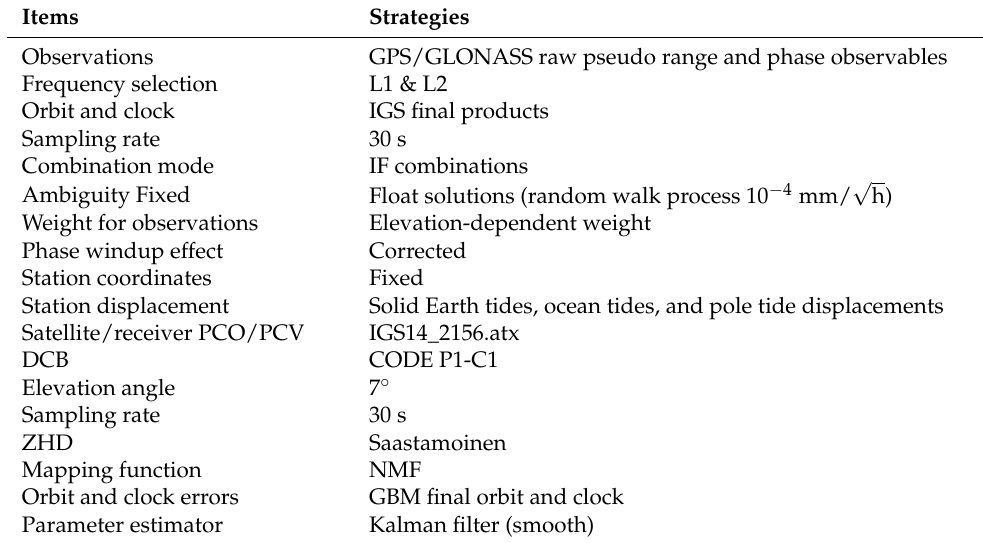
Figure 2. Distribution of GNSS stations in this study. Table 1. Strategies used in the PPP program. Table 1. Strategies used in the PPP